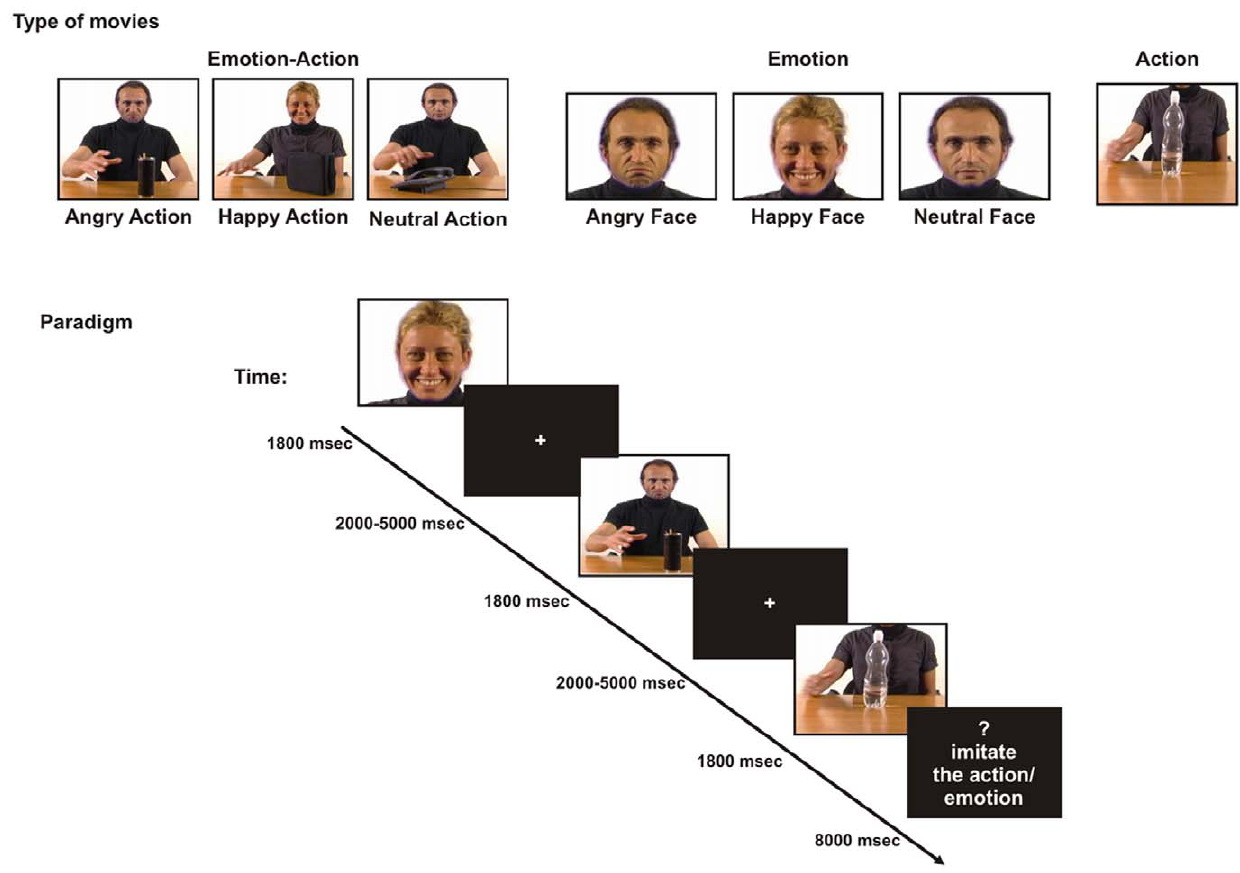
Figure 1. Stimuli and experimental paradigm. Examples of the three sets of coloured movies used in the visual stimulation. Lower panel: description of the experimental paradigm.